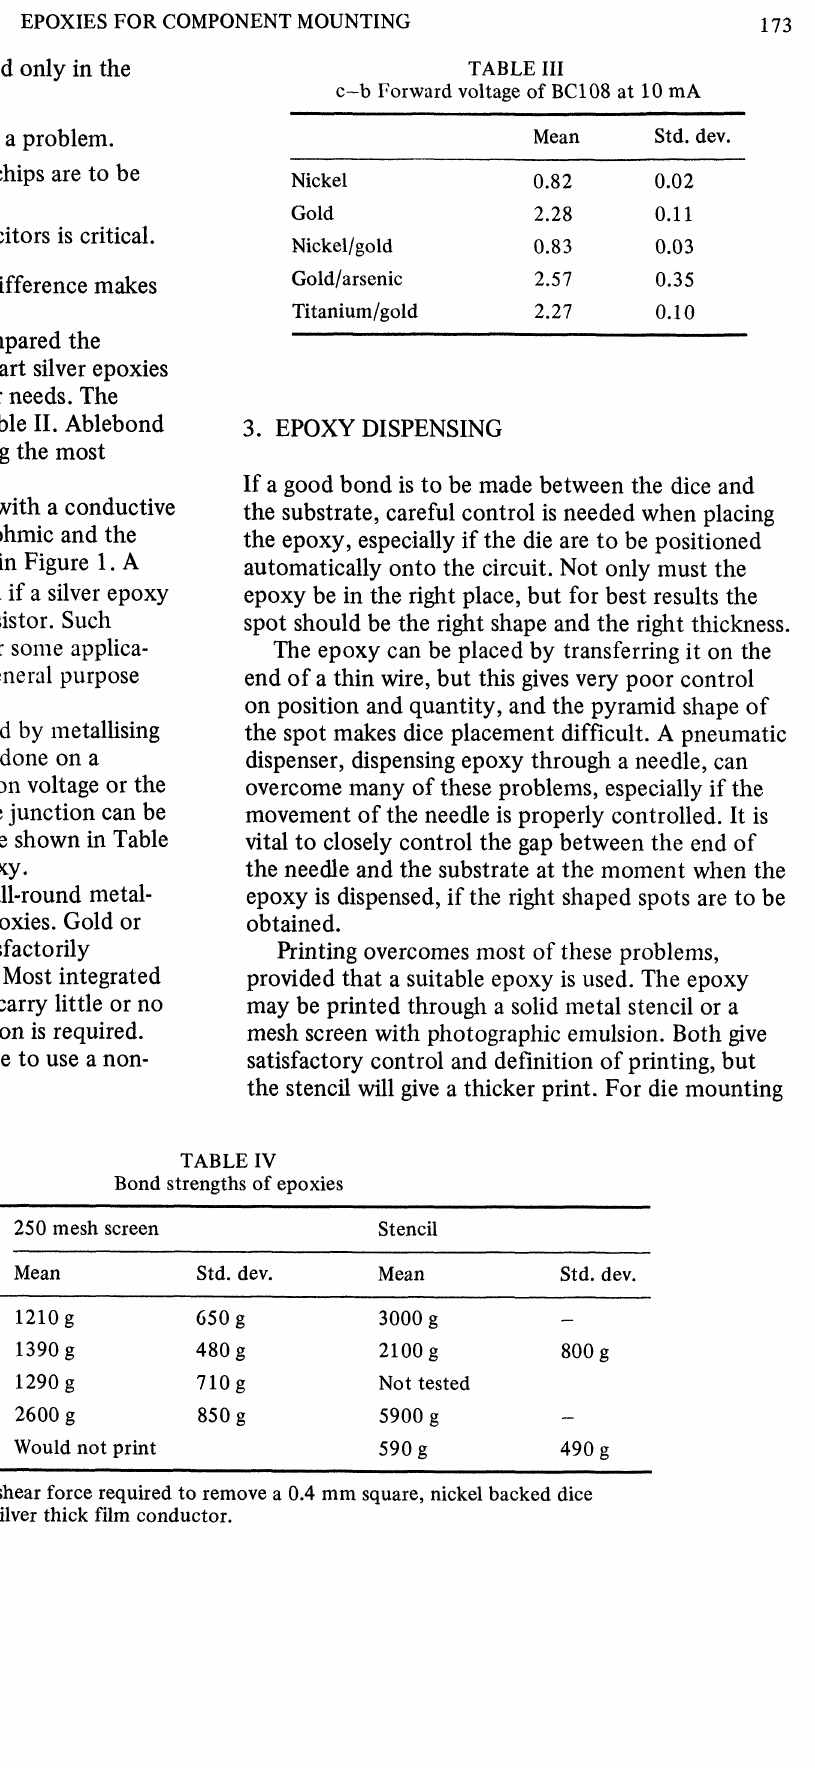
TABLE III c-b Forward voltage of BC108 at 10